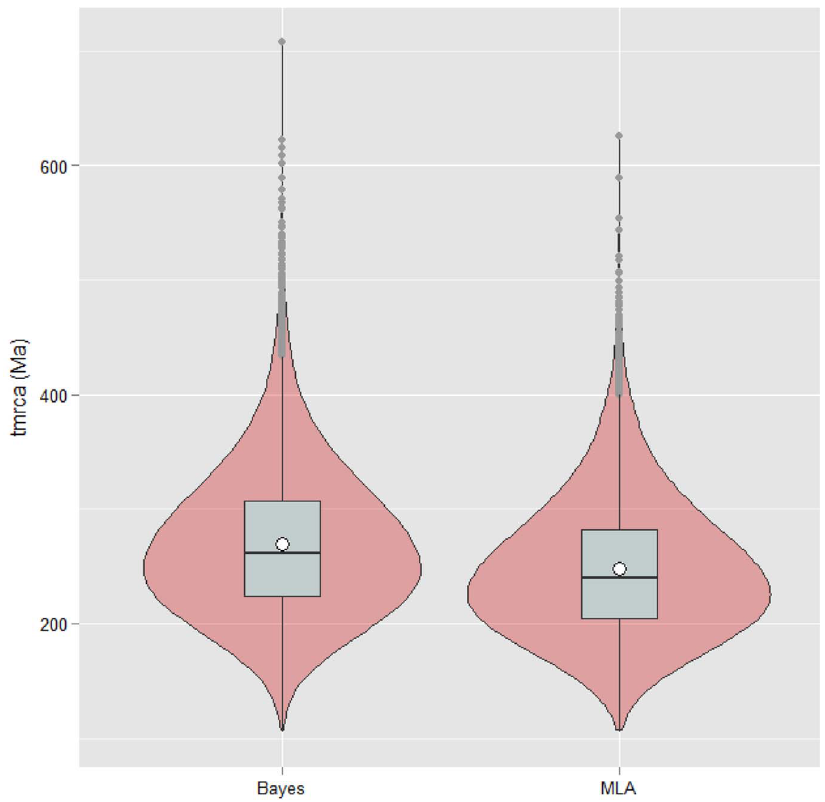
Figure 5. Violin plots of the tmrca distribution for Bayes and MLA simulated trees. The plots show the kernel density estimation of the data (mirrored curves) with a box and whiskers plot overlaid. The plots are scaled so each one has the same total area. The internal box plots indicate the range (whiskers), interquartile range (boxes), median (horizontal black lines) and mean (circles) of the data. The grey points on the plot tails indicate the outliers. See text for more details.